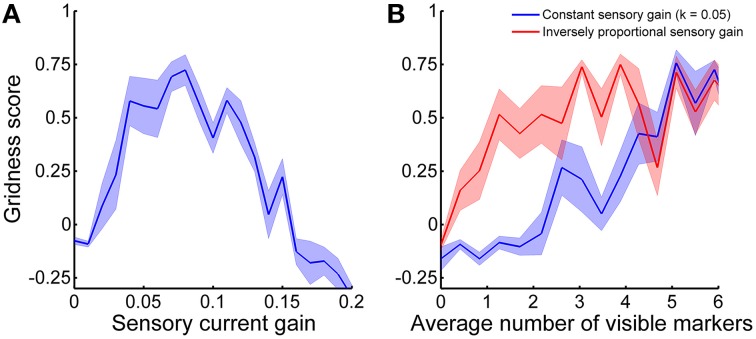
Gridness score average as a function of (A) sensory current gain and (B) average number of visible markers. The shadow areas represent the standard error of the mean. (A) The stabilization mechanism works best if velocity-dependent currents and sensory currents are balanced. (B) The optimal current sensory gain k depends on the average number of visible markers. The stabilization performance gets worse when the current sensory gain is constant (blue line) than when it is inversely proportional to the average number of visible markers (red line).